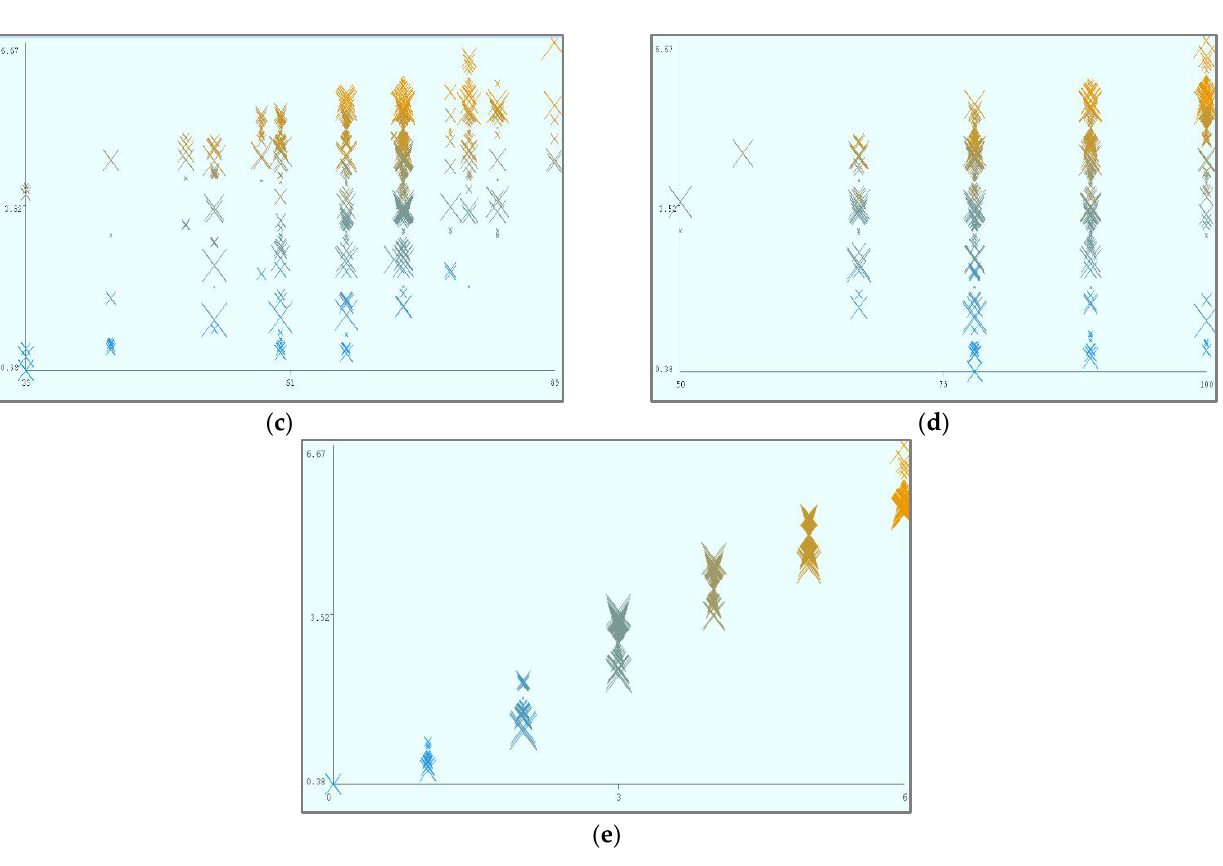
Figure 11. ( a ). Multilayer Perceptron error (X: Availability vs. Y: Predicted Ranking). ( b ). Multilayer Perceptron error (X: Security vs. Y: Predicted Ranking). ( c ). Multilayer Perceptron error (X: Reliability vs. Y: Predicted Ranking). ( d ). Multilayer Perceptron error (X: Cost vs. Y: Predicted Ranking). ( e ). Multilayer Perceptron error (X: Ranking vs. Y: Predicted Ranking).